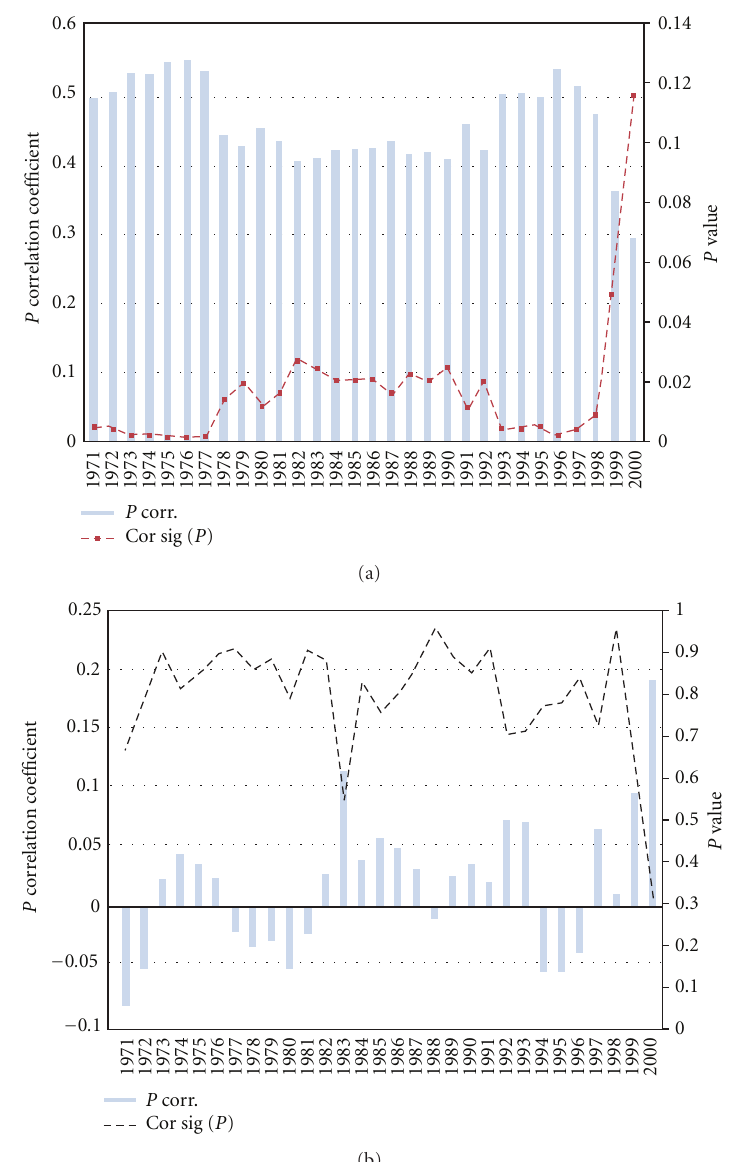
Figure 8: Moving partial correlation between (a) Zim SPI and IODZMI when Ni˜no 3.4 signal is removed; (b) Zim SPI and Ni˜no 3.4 when IODZMI signal is removed (bars) alongside corresponding running P values (broken lines). Partial correlation vales have been multiplied by − 1 for ease of comparison. Values are plotted as a function of the end year in the 31-year